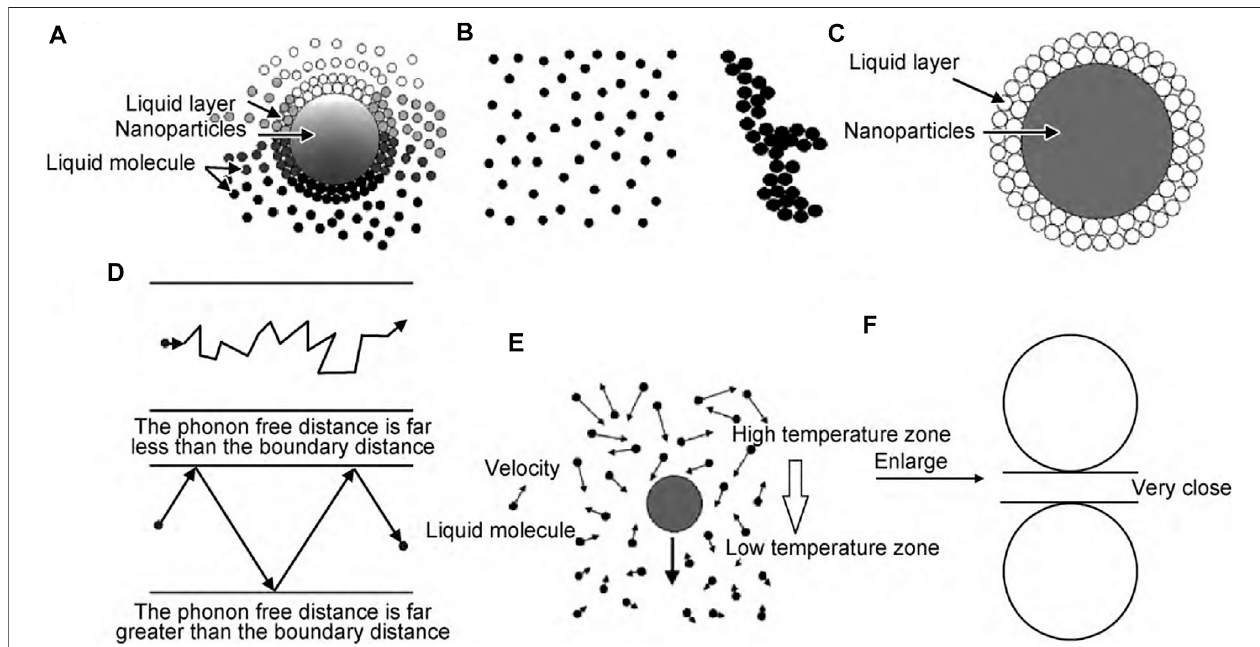
FIGURE 2 | Nano fl uid heat conduction mechanism. (A) Nanoparticle Brownian motion and microconvection, (B) Nanoparticle agglomeration and penetration, (C) Nanoparticle liquid layer, (D) Ballistic transport and nonlocal effects, (E) Thermophoresis theory, (F) Radiation heat transfer.